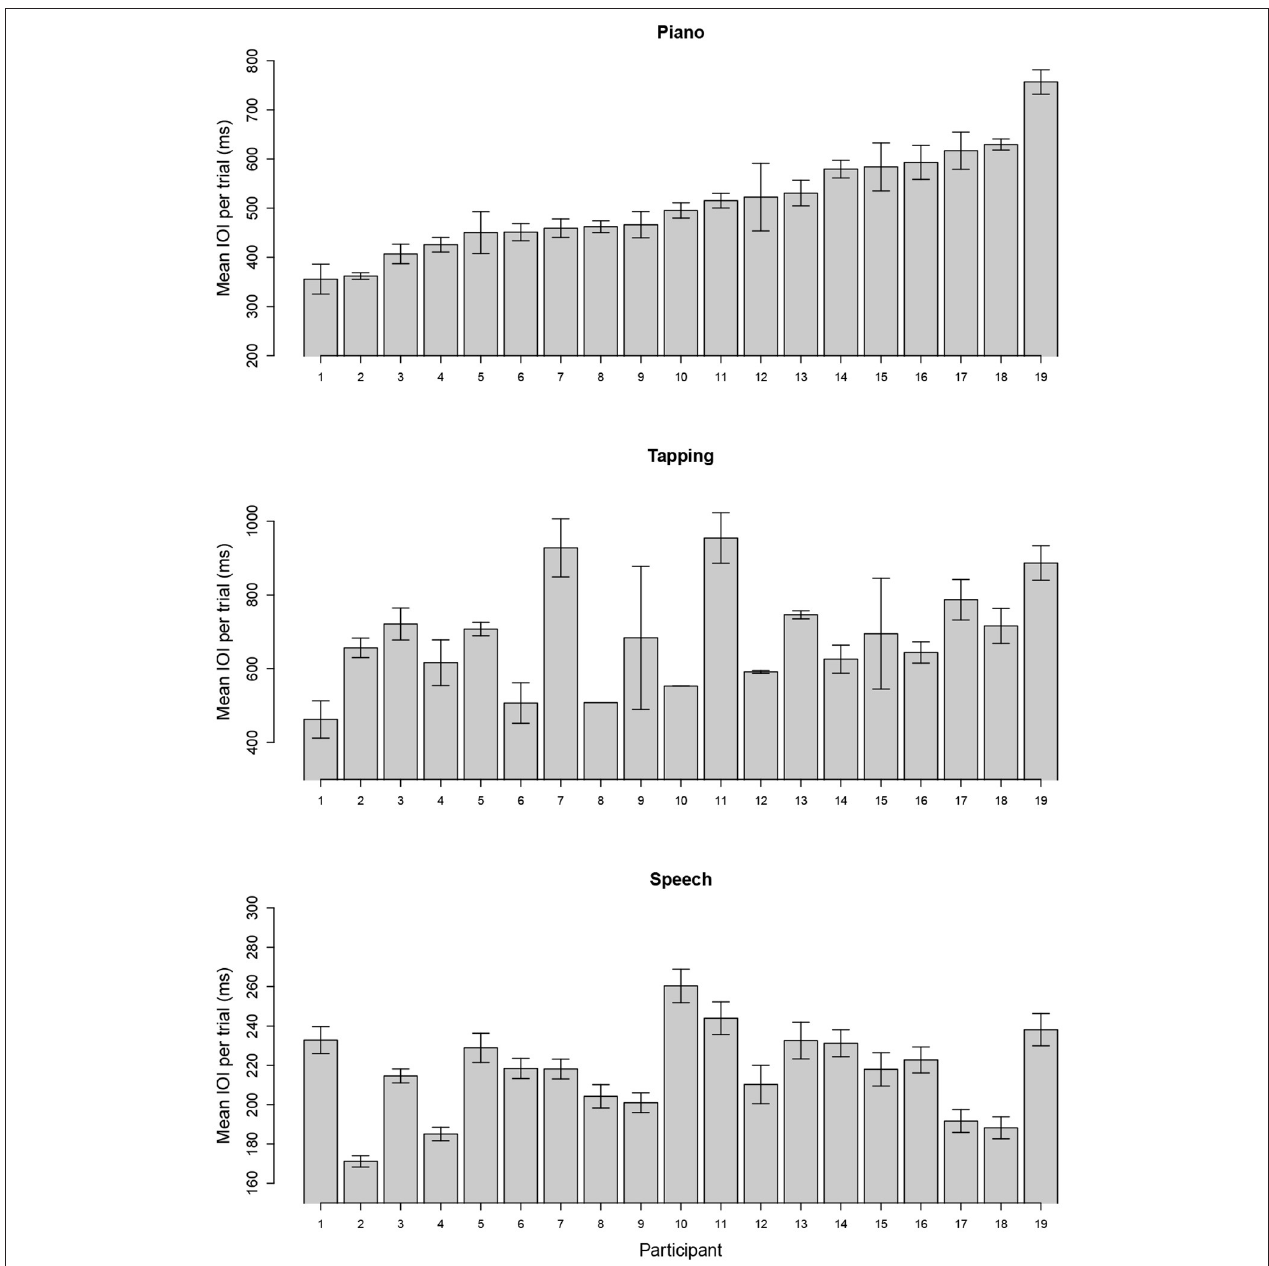
FIGURE 1 | Mean (SE) of spontaneous rate across trials using mean interonset interval (IOI) for each individual when producing melodies (top), rhythmic tapping (middle), and speech (bottom). Units are expressed in milliseconds (ms), and participants are ordered in both graphs according to their spontaneous rate in music. Note that maximum and minimum Y-axis values vary across panels to show range of individual differences.